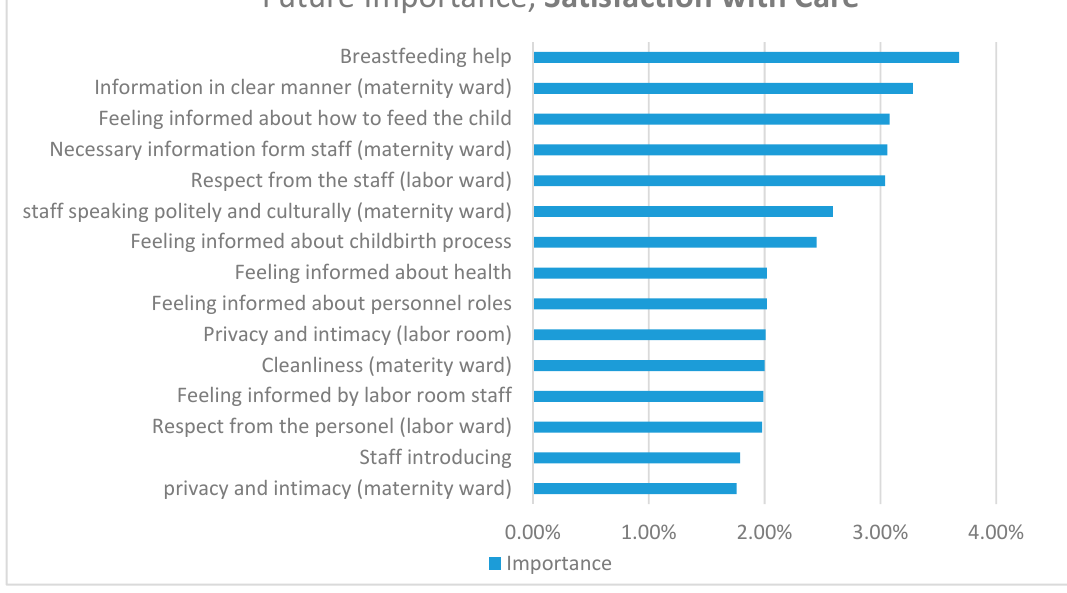
Figure 2. Most predictive variables for satisfaction with care.